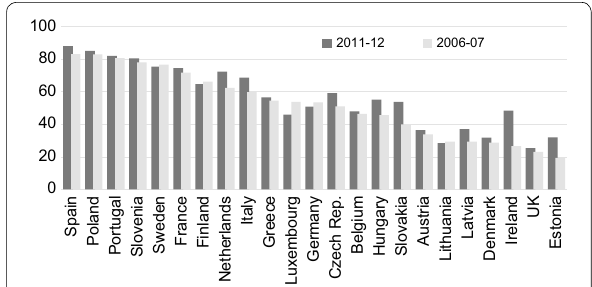
Fig. 2 Share of temporary contracts among new employment con- tracts ( Source OECD (2014, pp. 150))